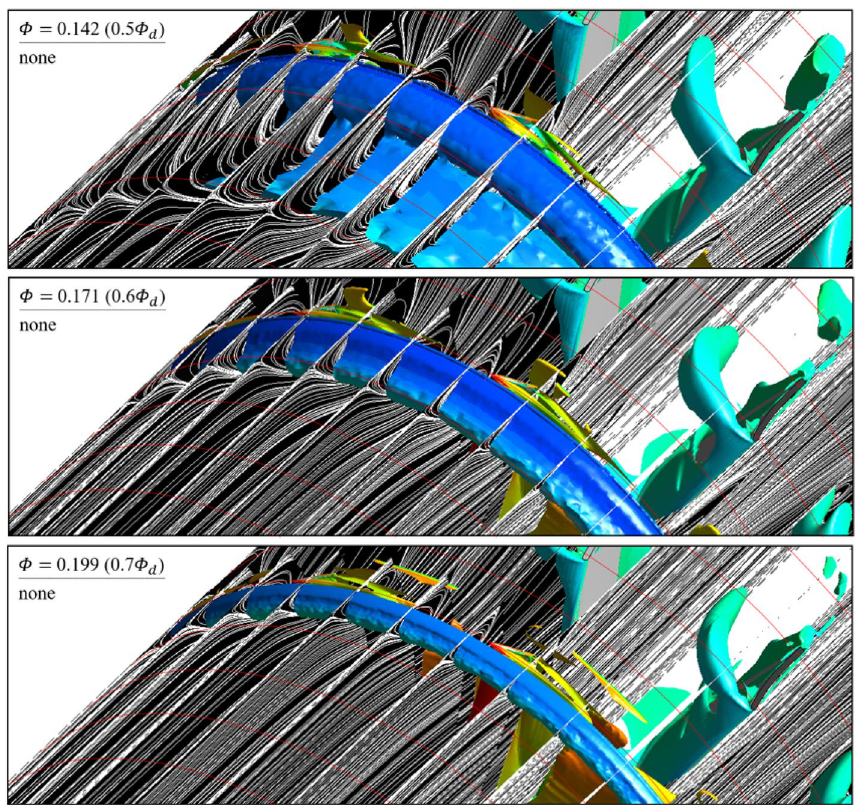
Figure 12. Internal flow field with limiting streamlines and Q -criterion for case of none (0.5–0.7 Φ d